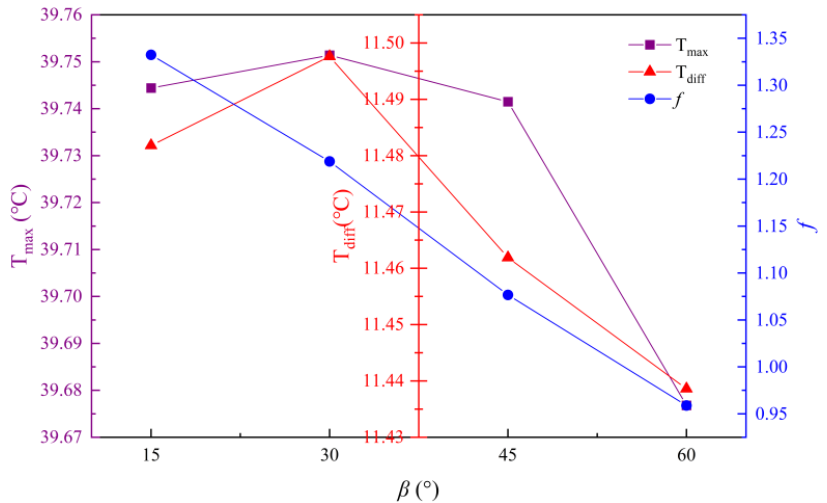
Figure 19. Influence of β on evaluation indexes.